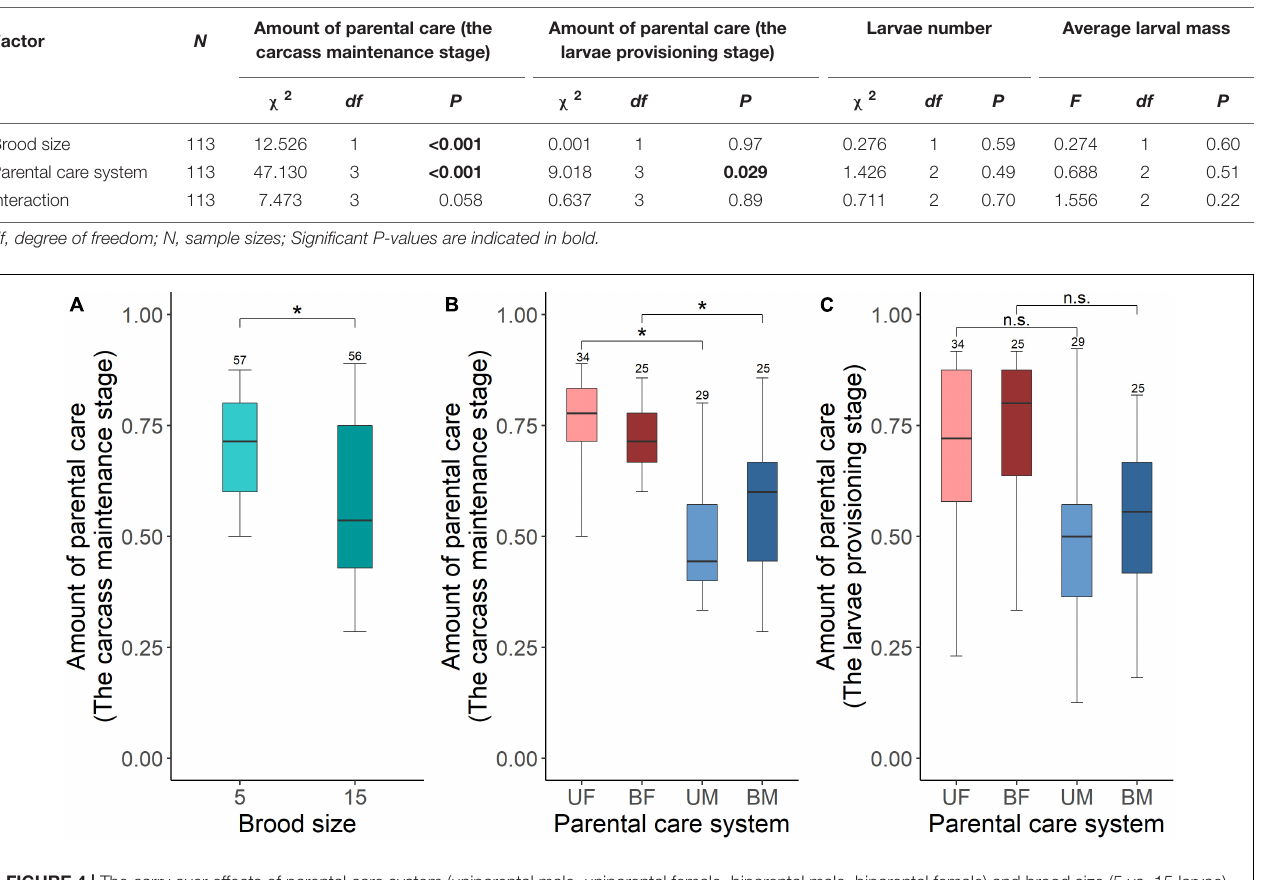
FIGURE 4 | The carry over effects of parental care system (uniparental male, uniparental female, biparental male, biparental female) and brood size (5 vs. 15 larvae) in the first breeding on the amount of parental care during the carcass maintenance stage [ (A) brood size (B) parental care system] and the larvae provisioning stage [ (C) parental care system] in the second breeding. Boxplots show median, interquartile range, and minimum/maximum range. Numbers above error bars are sample sizes. For statistical analyses see Tables 5 , 6 . Asterisks, significant ( P < 0.05); n.s., not significant; UM, uniparental male; UF, uniparental female; BM, biparental male; BF, biparental female. TABLE 6 | Pairwise comparison for the effect of parental care system (uniparental male, uniparental female, biparental male, and biparental female) in the first breeding on the amount of parental care during the carcass maintenance stage and the larvae provisioning stage in the second breeding.